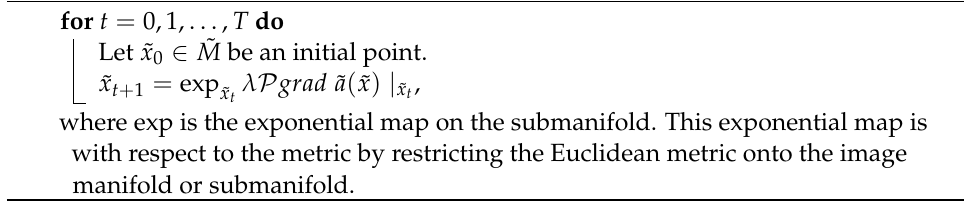
Algorithm 2 Gradient algorithms for optimization ˜ a ( ˜ x ) along the submanifold ˜ M . for t = 0, 1, . . . , T